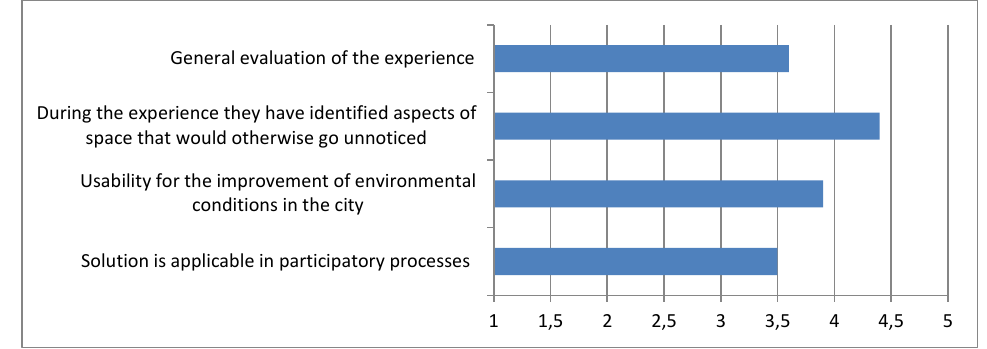
Figure 10: Participants’ evaluation of the experience and solution scored from 0 to 5. Mean of the evaluations (being 5 fully agree and 1 totally